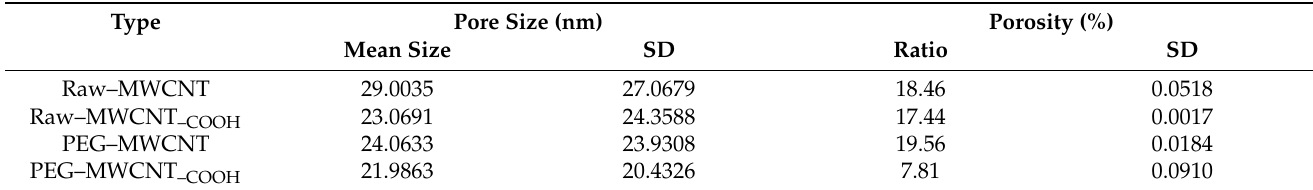
Table 2. Apparent mean pore diameter of PEG non-covalent-functionalized MWCNT membranes.